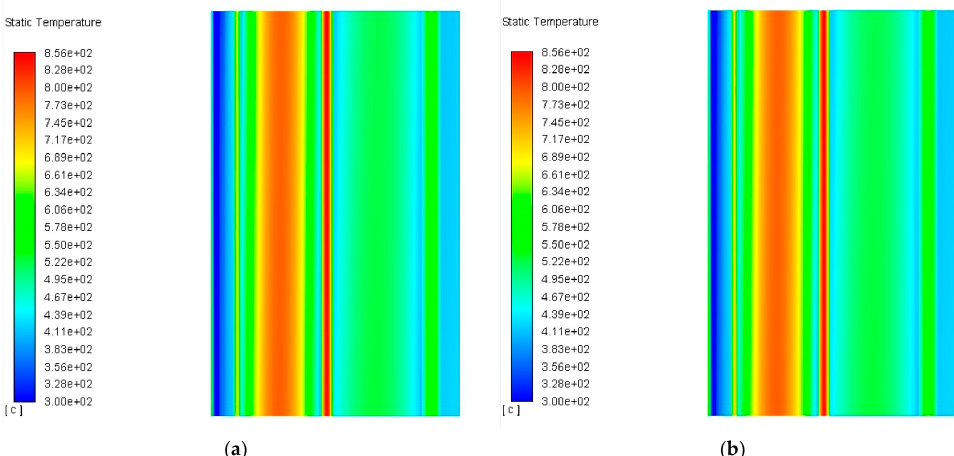
Figure 17. Temperature distribution in the HCSB blanket: ( a ) one-way N/TH coupling calculation; ( b ) two-way N/TH coupling calculation.